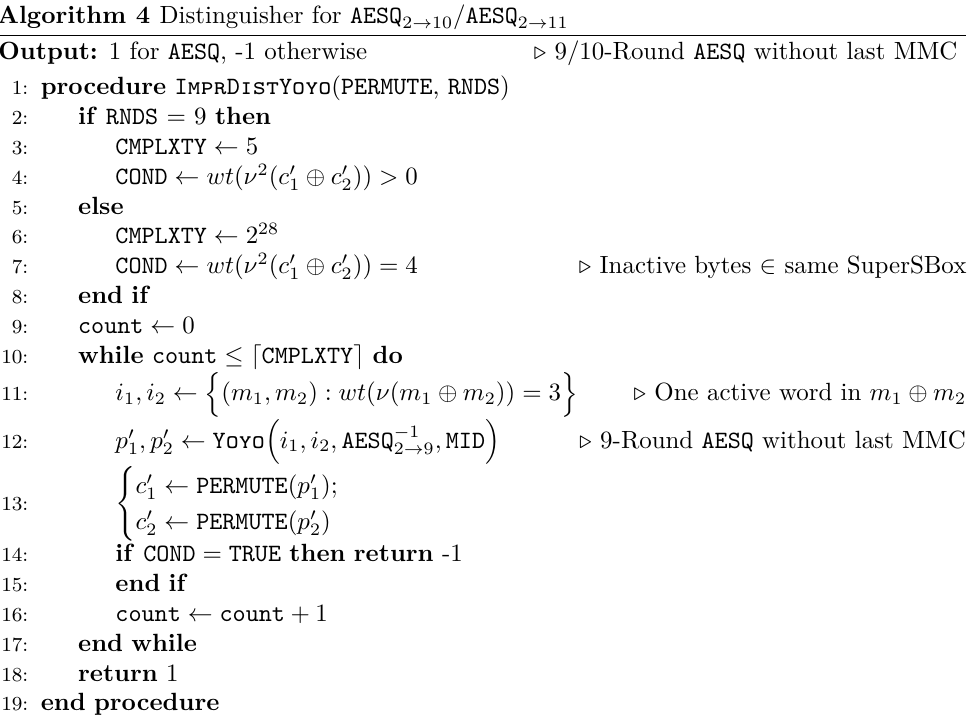
Algorithm 4 Distinguisher for AESQ